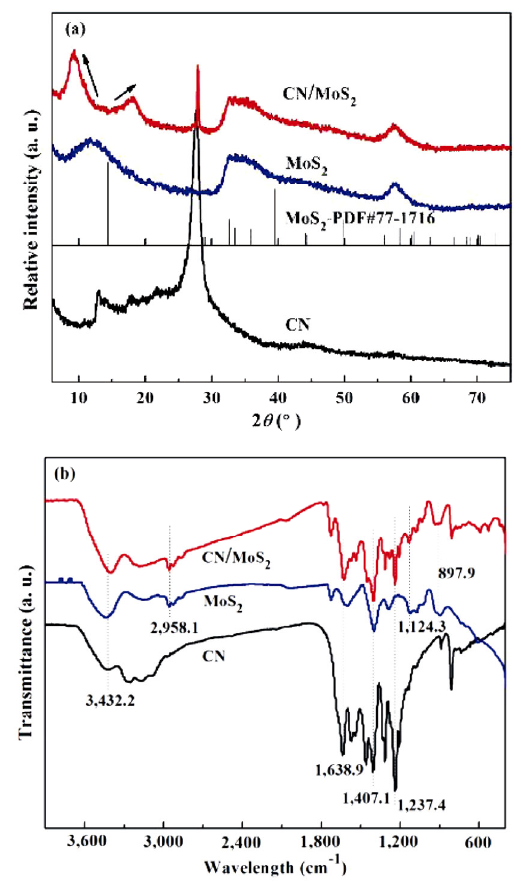
Fig. 1 (a) XRD and (b) FTIR patterns of CN, MoS 2 , and CN/MoS 2